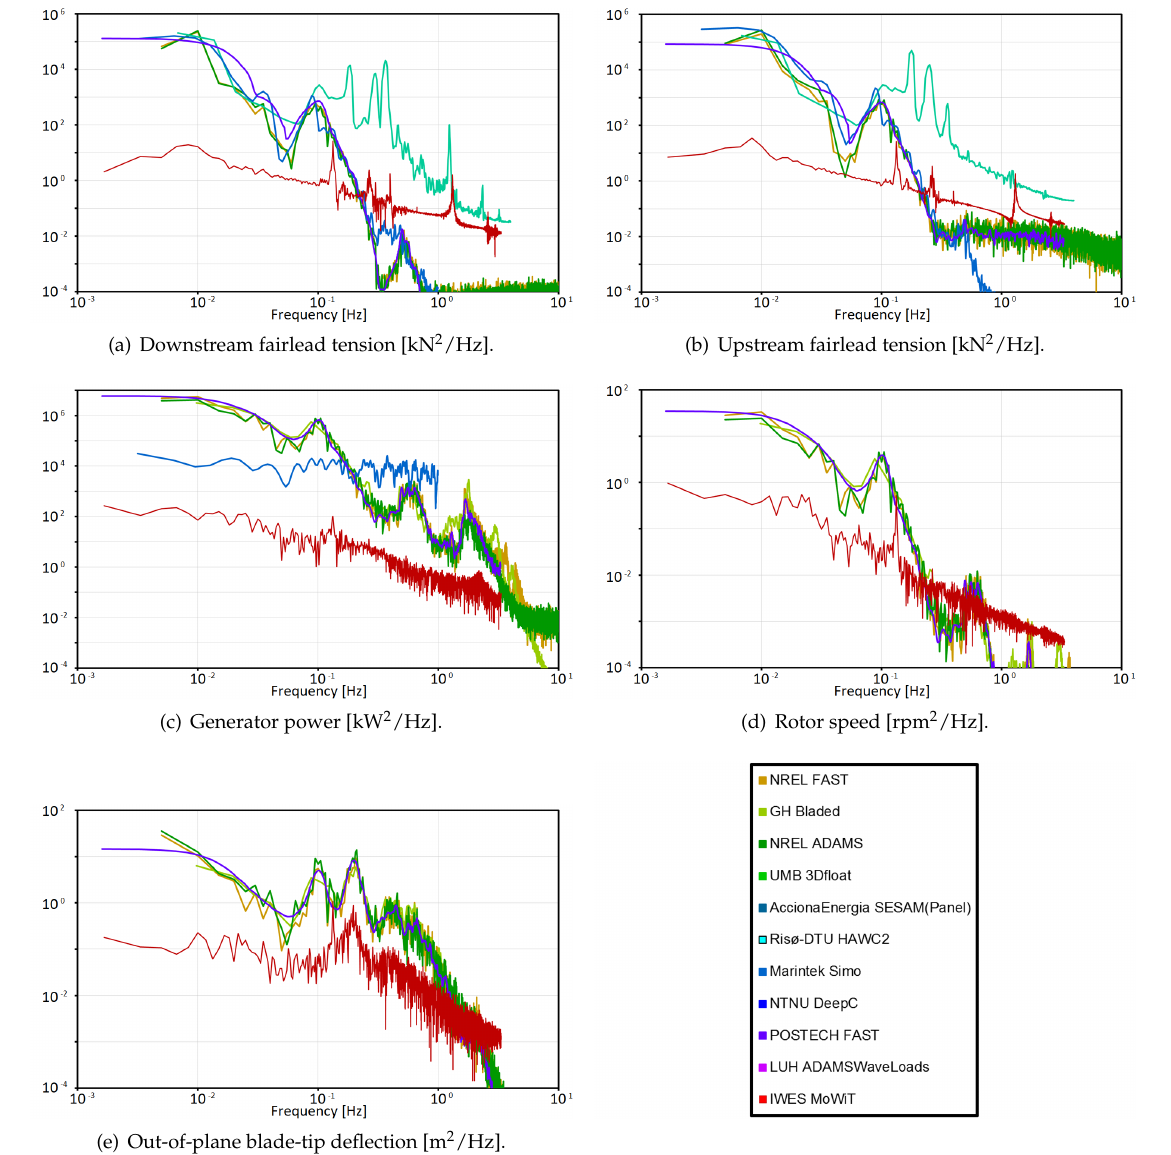
Figure 17. Aero-hydro-servo-elastic power spectra with irregular waves from LC 5.3, part